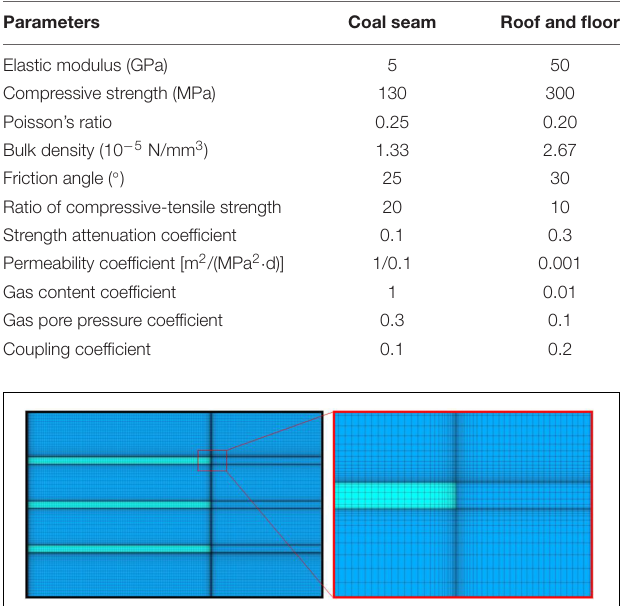
FIGURE 6 | The mesh for numerical